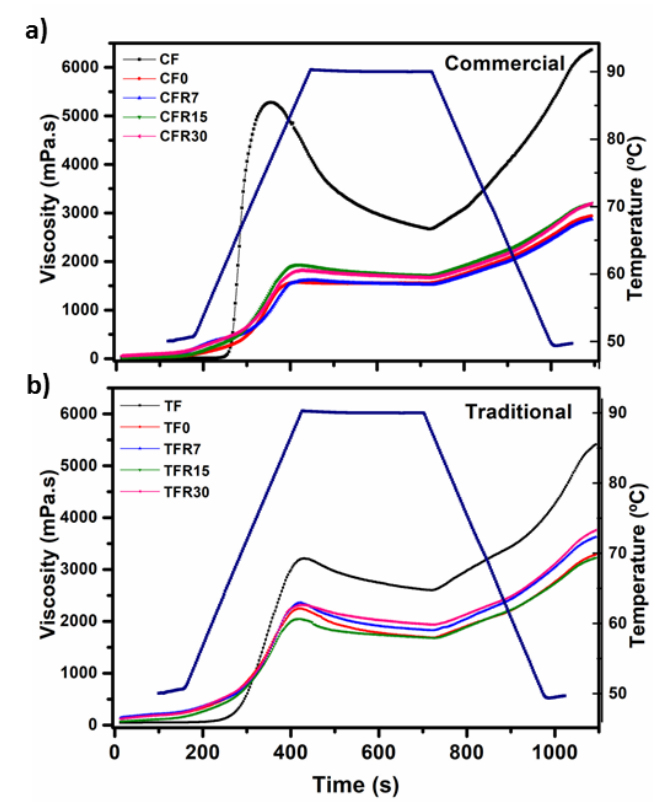
Figure 3. Pasting profiles of nixtamalized corn flours and corn tortilla flours obtained by the ( a ) industrial (commercial) and ( b ) traditional methods without refrigeration (TF, CF, TR0, CF0) and stored in refrigeration (4 °C) at different periods of time (7, 15, and 30 days).